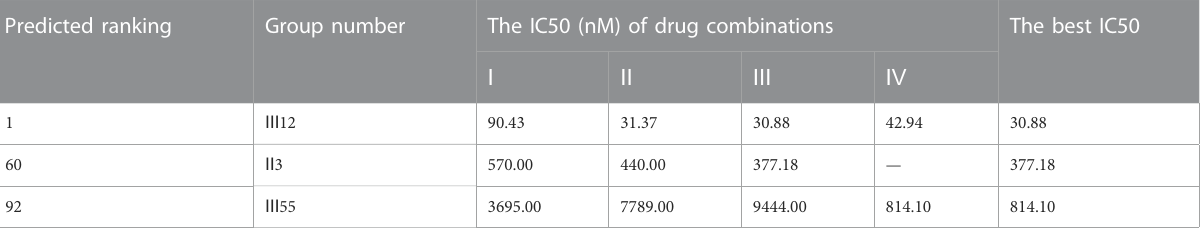
TABLE 6 The comparison results of anti-cancer effect between clinically used combinations and Ⅲ 12 on MCF-7 cell line. Predicted ranking Group number